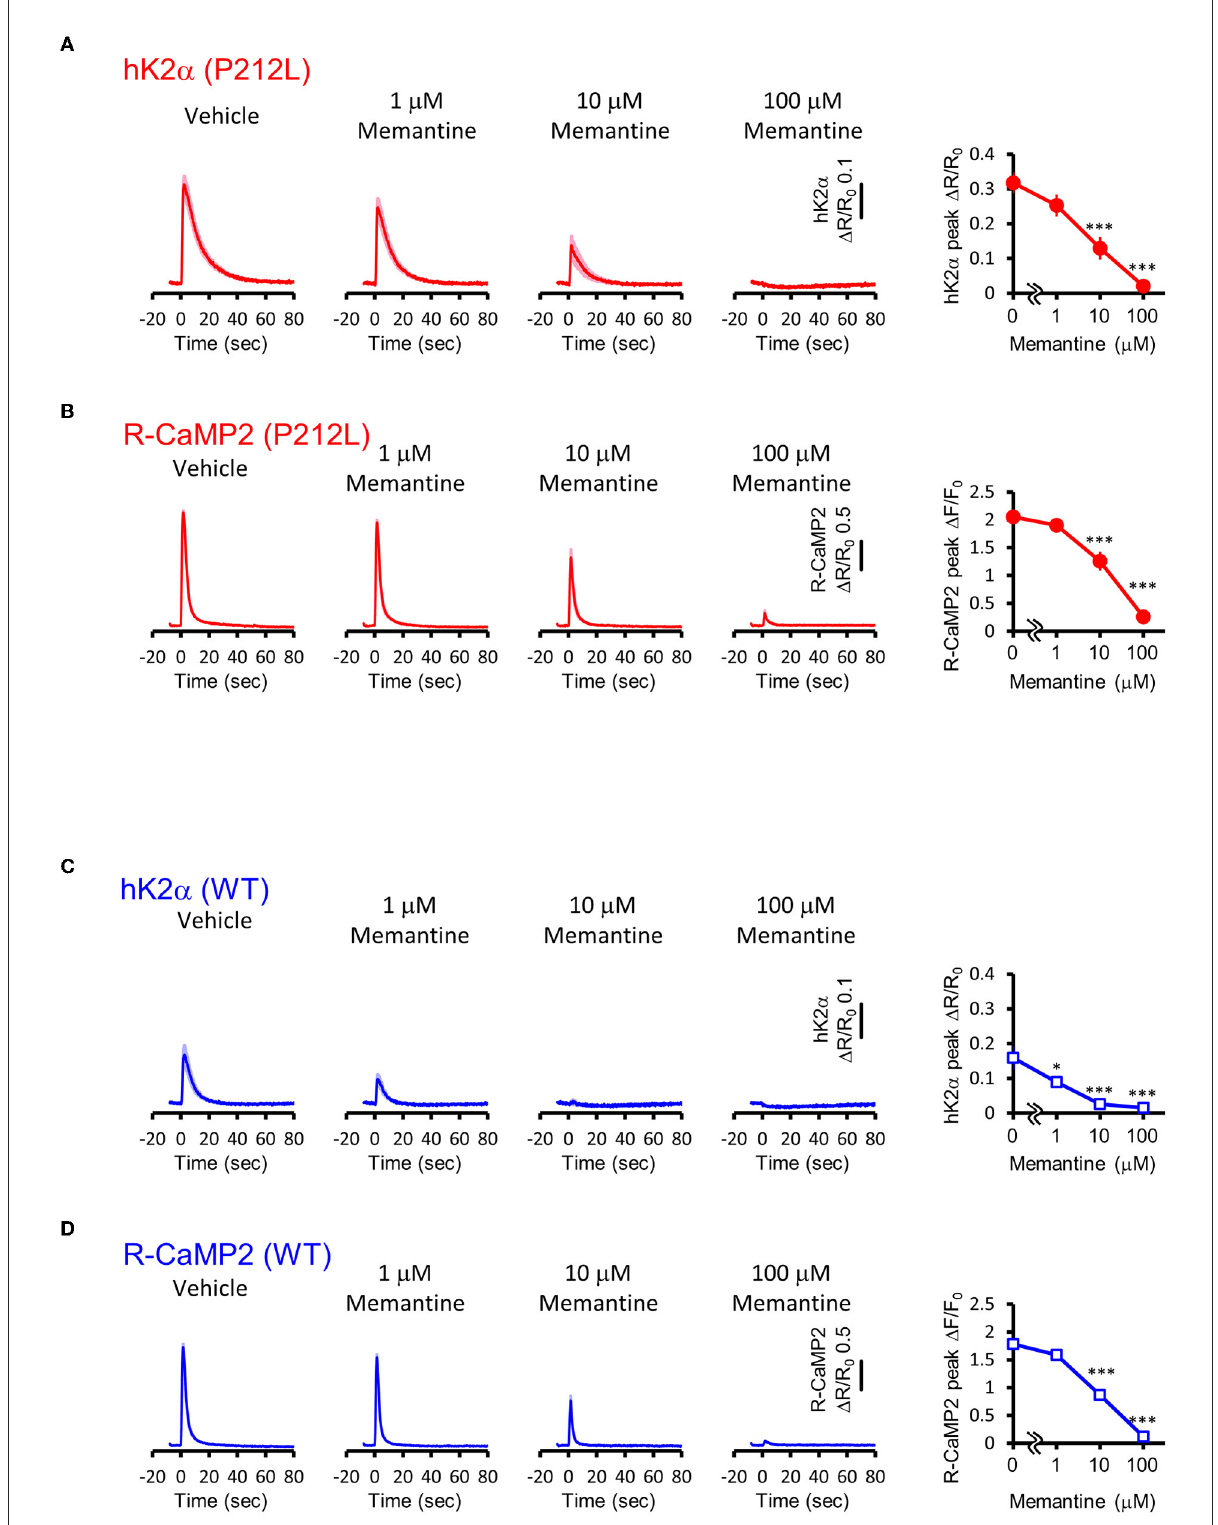
FIGURE8 Memantine suppressed augmented activation of P212L. (A) Activation traces (left) and dose-response curve (right) of hK2 α P212L in response to 30 photo-stimulations delivered at 20Hz under 0, 1, 10, 100 µ M memantine. n = 22 for 0 µ M, 27 for 1 µ M, 23 for 10 µ M and 22 for 100 µ